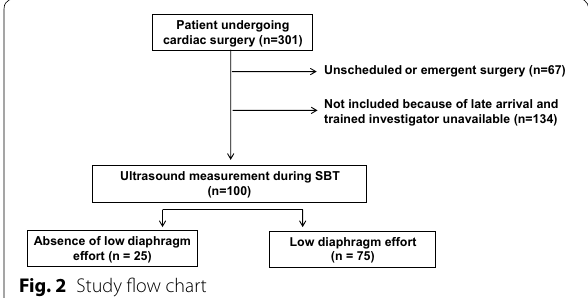
Data are presented as mean and standard deviation, median with first and third quartile or number [–] and percentages () TV tidal volume, RR respiratory rate, SBT spontaneous breathing trial, bpm beats per minute, TF thickening